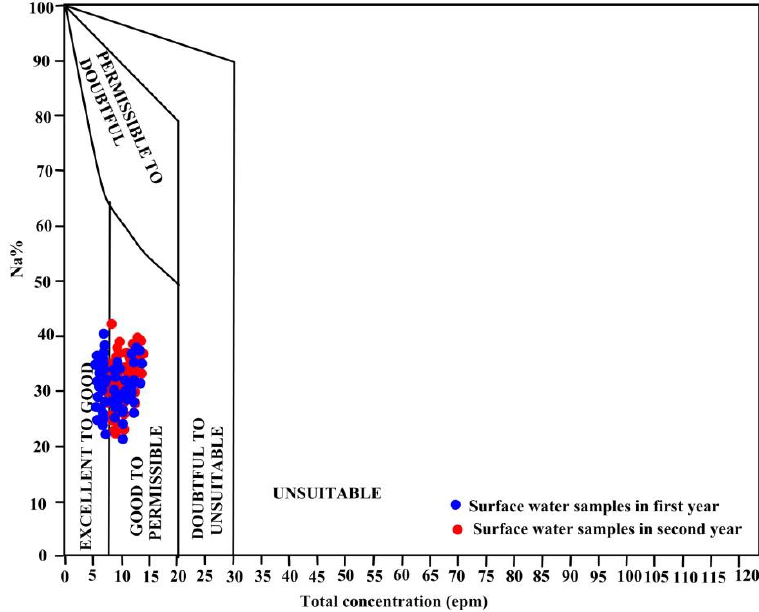
Figure 7. Wilcox Diagram to assess surface water quality for irrigation in two years.